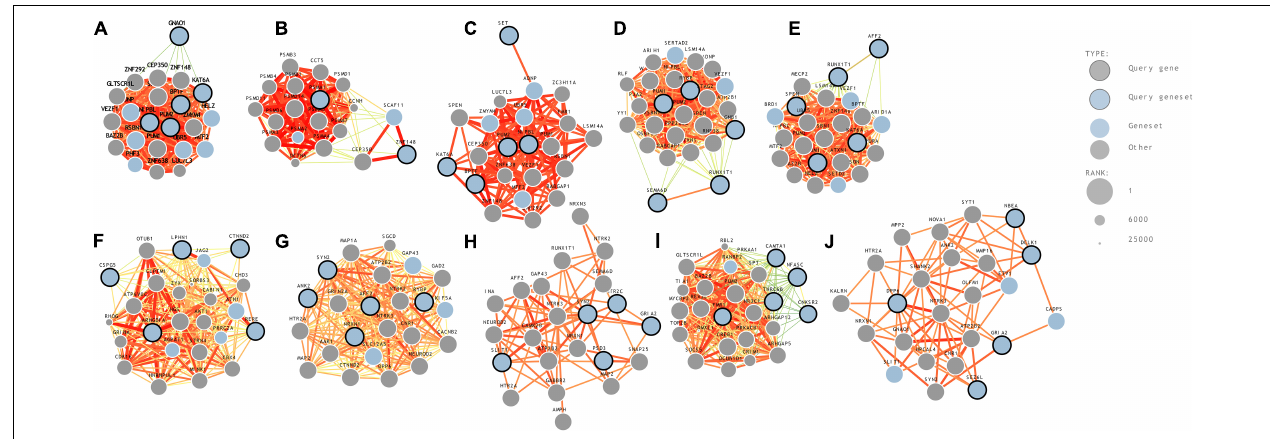
FIGURE 2 | Genome-wide prediction of ASD-associated genes specific to temporospatial features. (A) posteroventral parietal cortex, (B) primary visual cortex, (C) posterior superior temporal cortex, (D) striatum, (E) orbital frontal cortex, (F) anterior cingulate cortex, (G) dorsal thalamus, (H) amygdaloid complex, (I) primary auditory cortex, and (J)